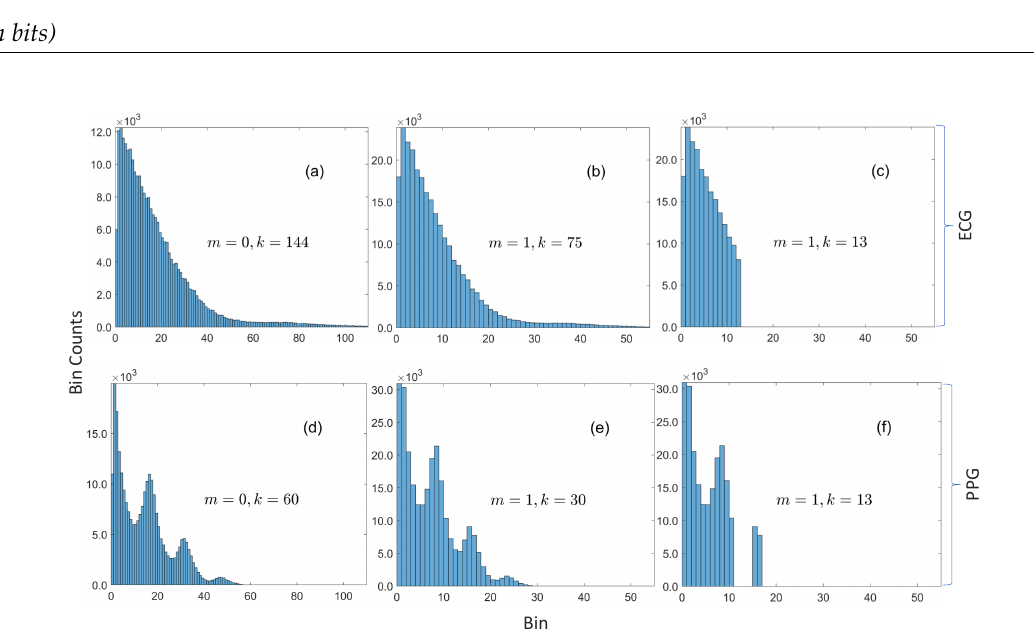
Figure 2. Histograms of magnitudes of residuals for ECG and PPG. ( a ) ECG with bin width = 1 is sparse (with respect to the underlying dictionary of 2 14 possible values) with only 144 bins with nonzero counts. ( b ) The number of bins with nonzero counts is approximately halved when the bin width is increased to 2. ( c ) The 13 most frequent bins are in contiguous slots. ( d ) PPG with bin width = 1 is also sparse with only 60 bins with nonzero counts. ( e ) The number of bins with nonzero counts is halved when the bin width is increased to 2, and the distribution still retains the same multimodal form. ( f ) The 13 most frequent bins are not all in contiguous slots, which demonstrates how the proposed method can sift out modes in multimodal